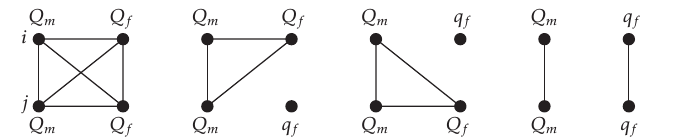
Figure 1: Possible alleles-shared IBD for individuals i and j in inbreeding backcross families. Lines indicate alleles-shared